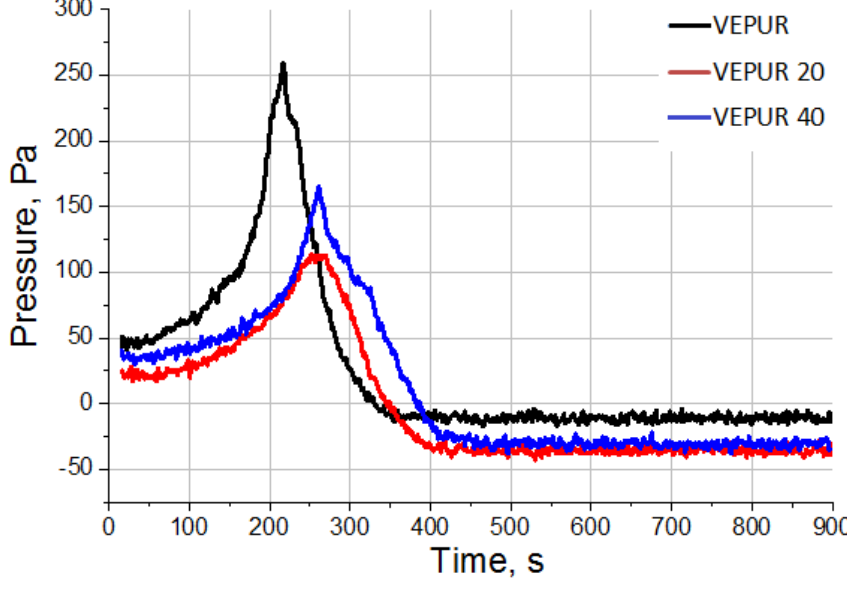
Figure 6. Pressure during the foaming process changes depending on the filler content in the poly- urethane formulation.